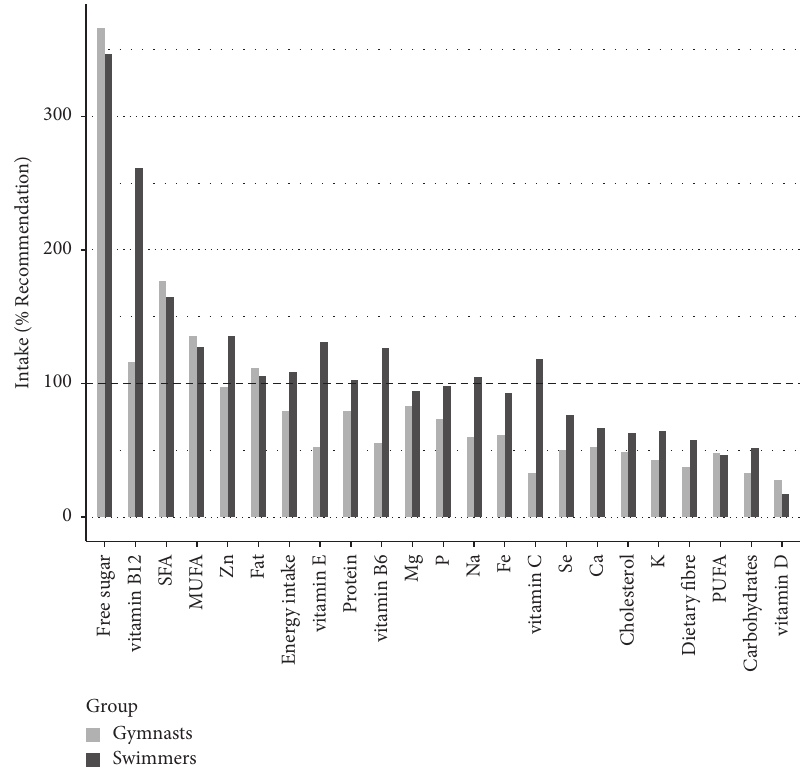
Figure 1: Dietary intake of elite-level artistic gymnasts and swimmers compared with recommendations